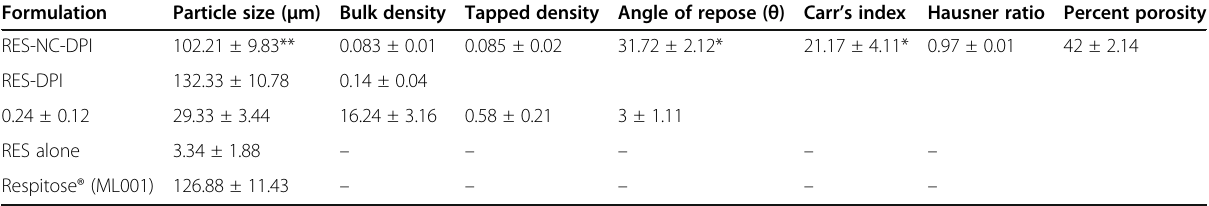
Table 2 Particle size and flowability properties of RES-NC-DPI and RES-DPI (mean ± SD, n = 3) Formulation